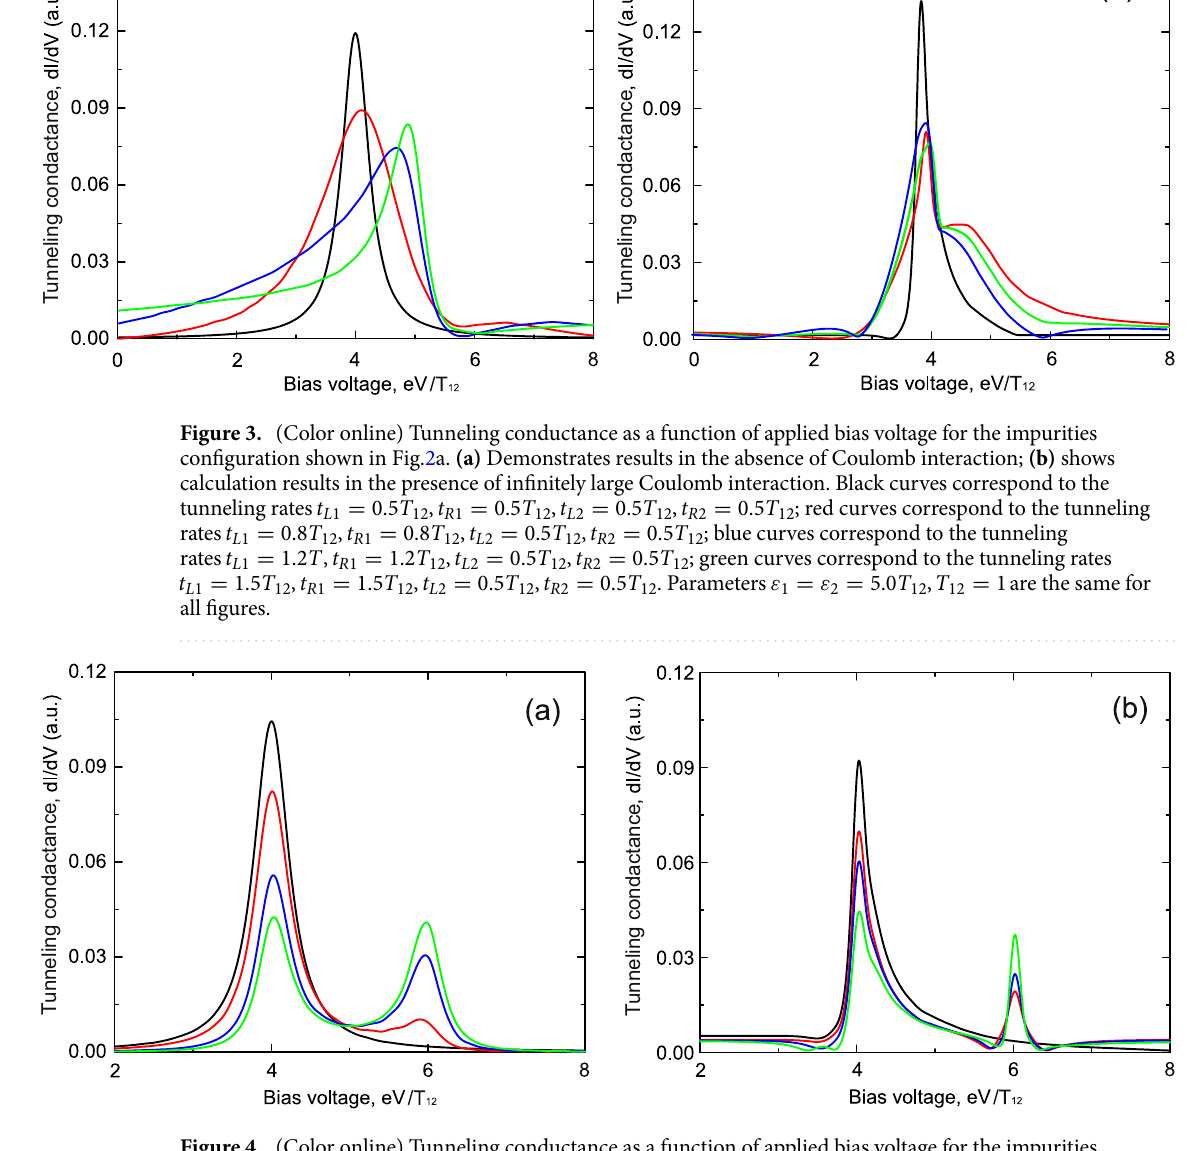
Figure 4. (Color online) Tunneling conductance as a function of applied bias voltage for the impurities configuration shown in Fig.2b. (a) Demonstrates results in the absence of Coulomb interaction; (b) shows calculation results in the presence of infinitely large Coulomb interaction. Black curves correspond to the tunneling rates t L 1 = 0.4 T 12 , t R 1 = 0.4 T 12 , t L 2 = 0.4 T 12 , t R 2 = 0.4 T 12 ; red curves correspond to the tunneling rates t L 1 = 0.4 T 12 , t R 1 = 0.15 T 12 , t L 2 = 0.15 T 12 , t R 2 = 0.4 T 12 ; blue curves correspond to the tunneling rates t L 1 = 0.4 T 12 , t R 1 = 0.04 T 12 , t L 2 = 0.04 T 12 , t R 2 = 0.4 T 12 ; green curves correspond to the tunneling rates t L 1 = 0.4 T 12 , t R 1 = 0.002 T 12 , t L 2 = 0.002 T 12 , t R 2 = 0.4 T 12 . Parameters ε 1 = ε 2 = 5.0 T 12 , T 12 = 1 are the same for all